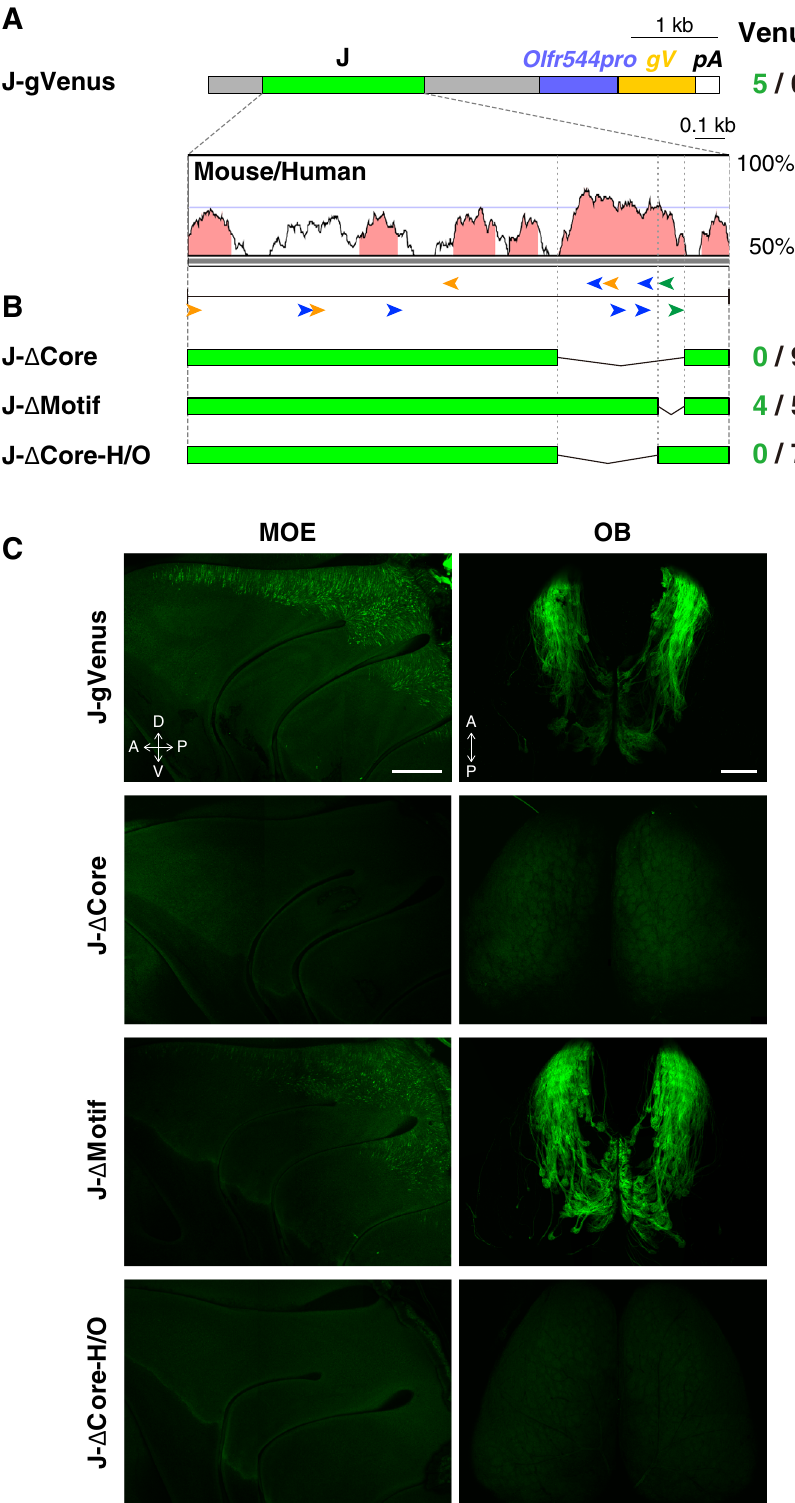
Figure 1. The 330-bp core J-H/O region, but not the class I-specific conserved motif, is necessary for the enhancer activity of the J element. ( A ) The J-gVenus transgene construct and schematic representation of putative binding motifs of the homeodomain site (blue arrowheads), O/E-like sites (orange arrowheads), and class I-specific conserved motif, the AAA CTT TTC site (green arrowheads), in the J element, together with the VISTA plot between mouse and human. Olfr544pro , promoter region of Olfr544 ; gV , membrane-targeted Venus reporter ( gapVenus ); pA , polyadenylation sequence. The number of reporter-positive independent founders and lines among the total analyzed is shown on the right 13 . ( B ) Deletion series of the J-gVenus transgene. The number of gapVenus-positive independent founders out of the total number analyzed is shown on the right. ( C ) Whole-mount fluorescent images of the turbinate of MOE and the dorsal OB of J-gVenus, J-ΔCore, J-ΔMotif, and J-ΔCore-H/O Tg founder mice. The scale bar is 500